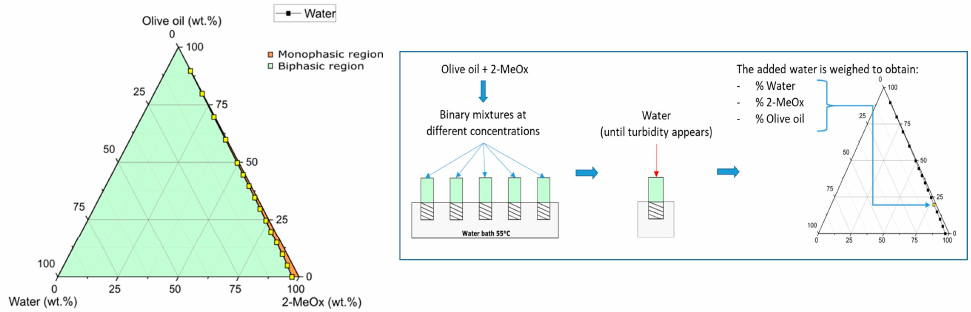
Figure 5. Ternary phase diagram at 55 °C of olive oil/2-MeOx/water.